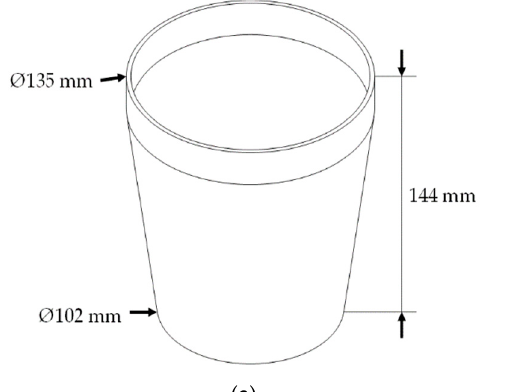
Figure 6. The view of tribocharging containers made of: ( a ) PET-G, ( b ) PLA/ABS, ( c ) ASA, ( d ) PP, ( e ) assembled container, air filter and airflow in suction head.